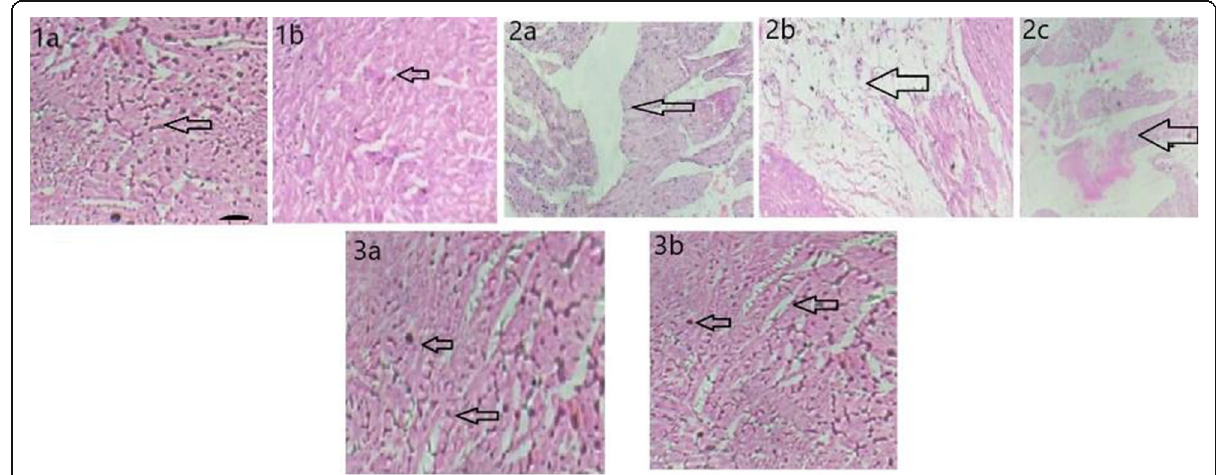
Fig. 3 ( a ) Photomicrograph of a section in cardiac muscles of control group ( 1a , 1b ), ( b ) hypertensive group ( 2a , 2b , 2c ), and ( c ) treated